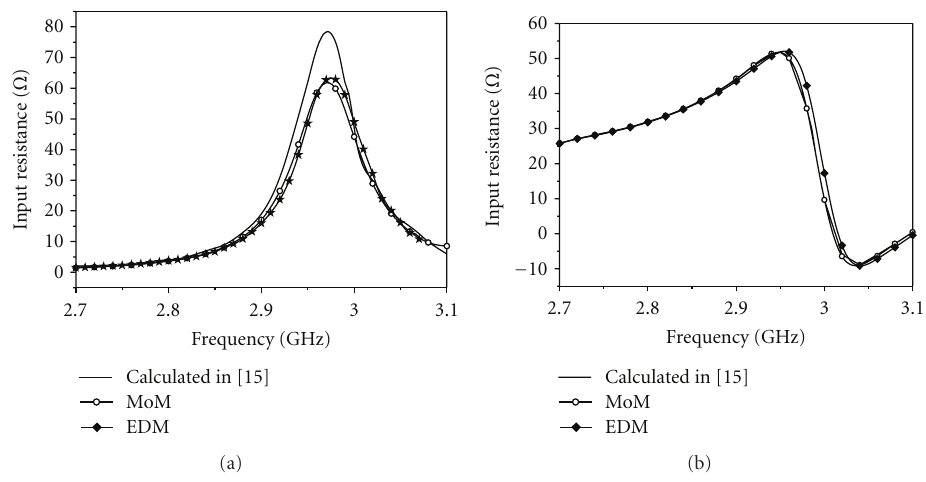
Figure 4: Input impedance of the planar microstrip antenna. (a) Input resistance. (b) Input reactance.